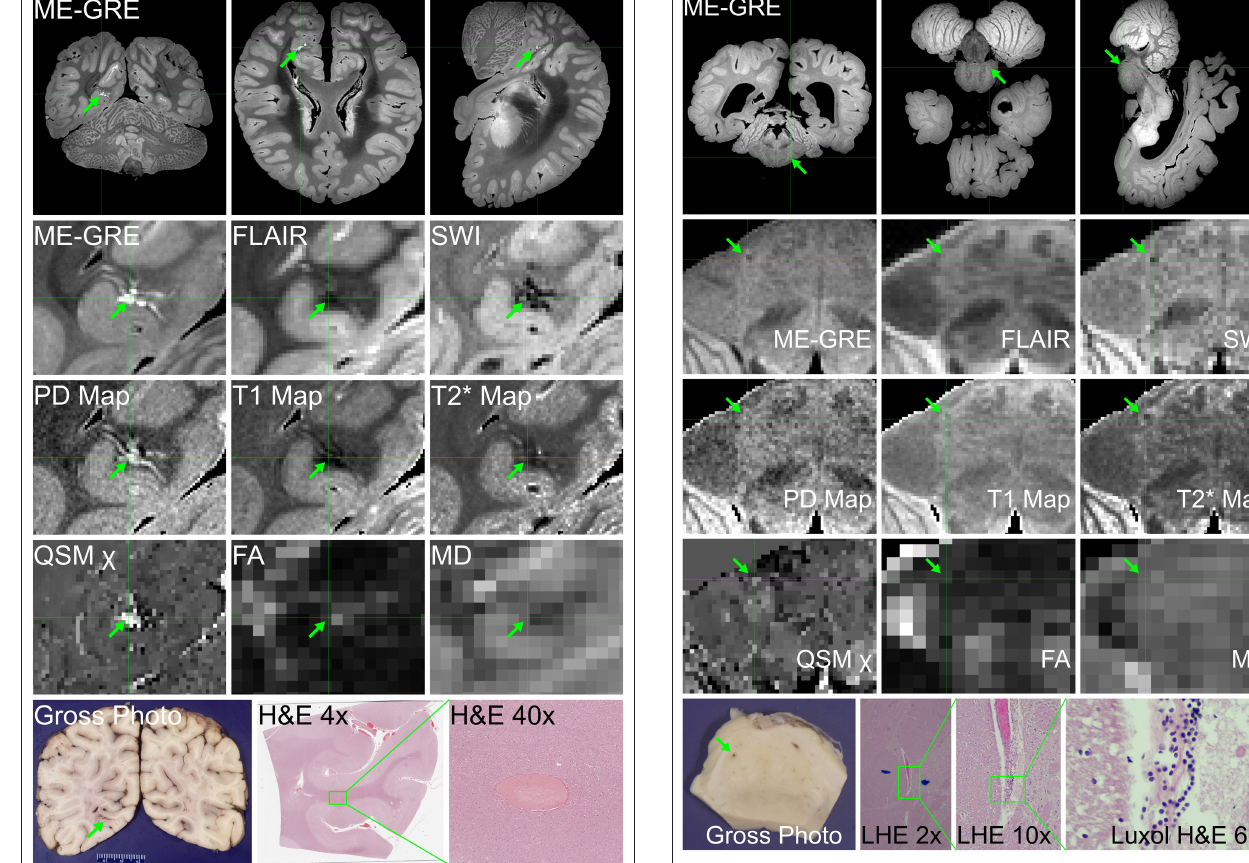
FIGURE 5 | Ex vivo MRI and autopsy neuropathology in Case 6. Ex vivo MRI findings of hyperintensity on multi-echo gradient-echo (ME-GRE), hypointensity on FLAIR and SWI, T 1 and T * 2 shortening, and high proton density (PD) and susceptibility ( χ ) in the right occipital lobe, consistent with a developmental venous anomaly, histologically confirmed, attesting to our ability to distinguish COVID-19-related findings from other pathologic, incidental findings in ex vivo MRI.